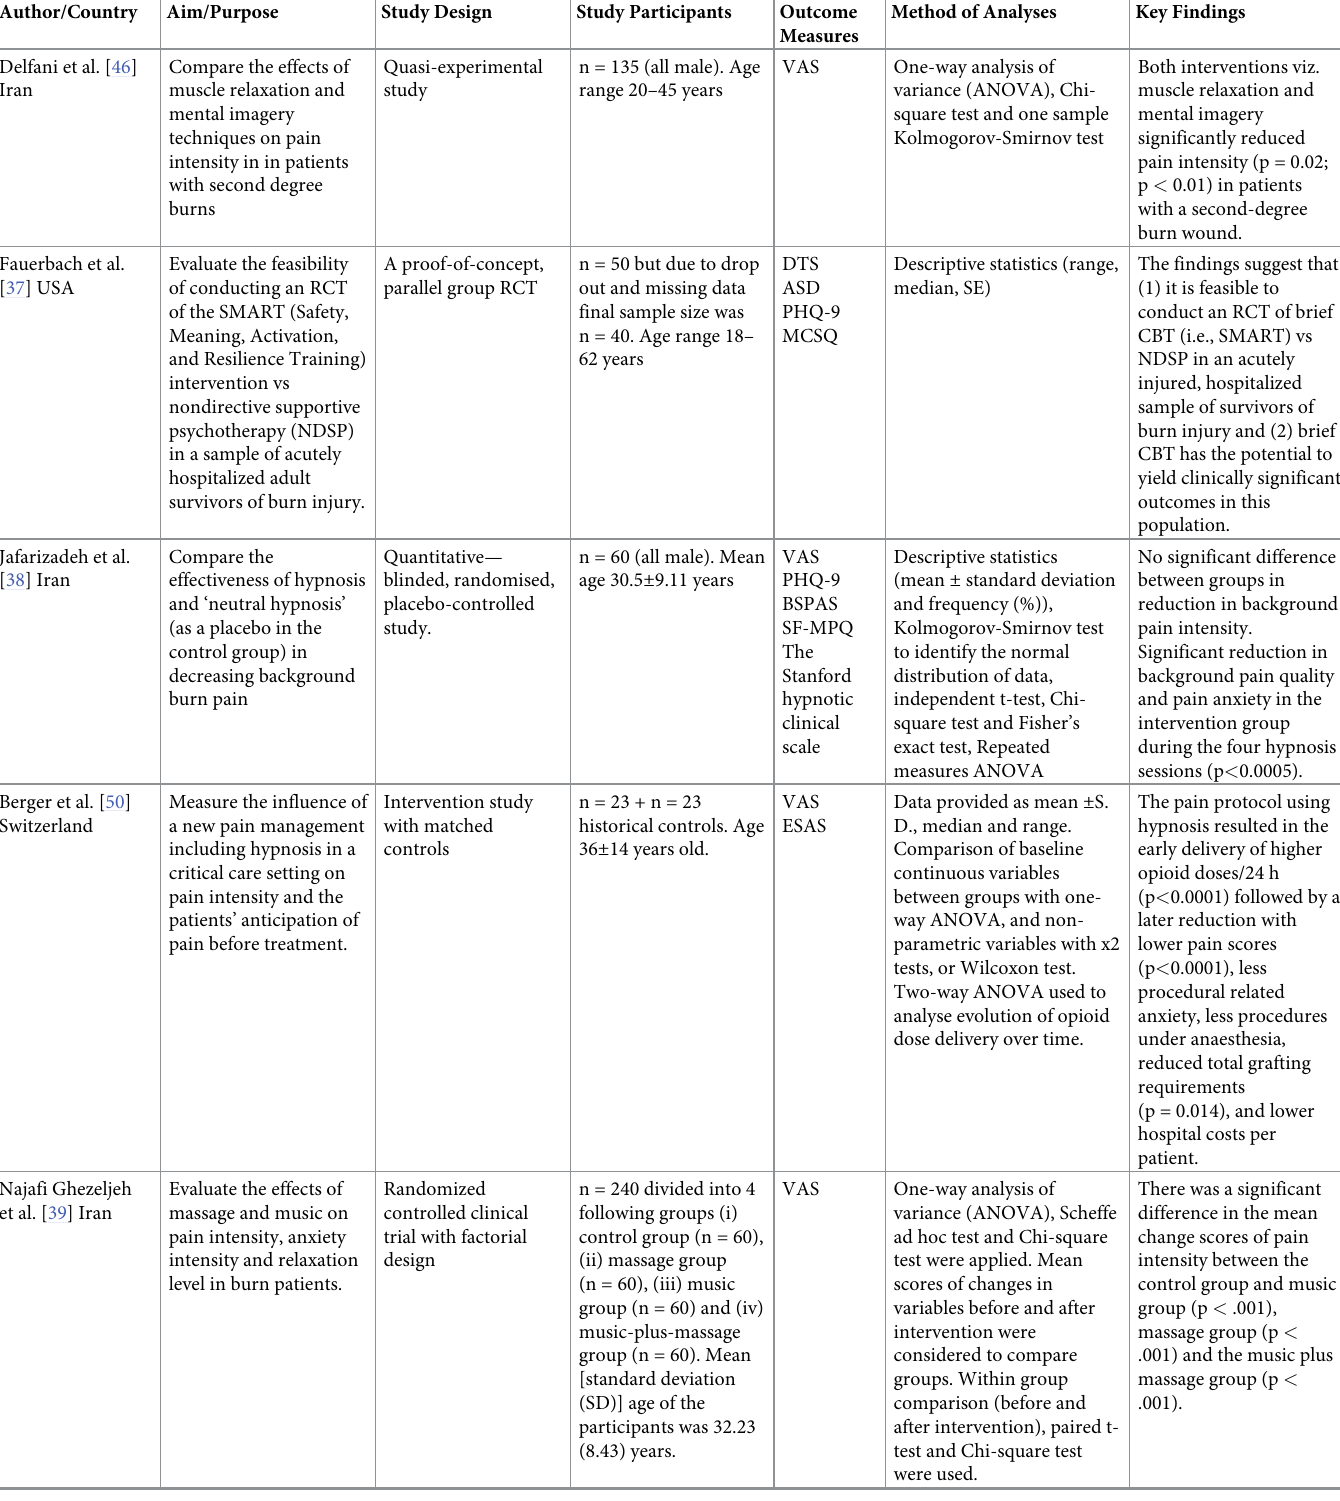
Table 2. Characteristics of the included quantitative